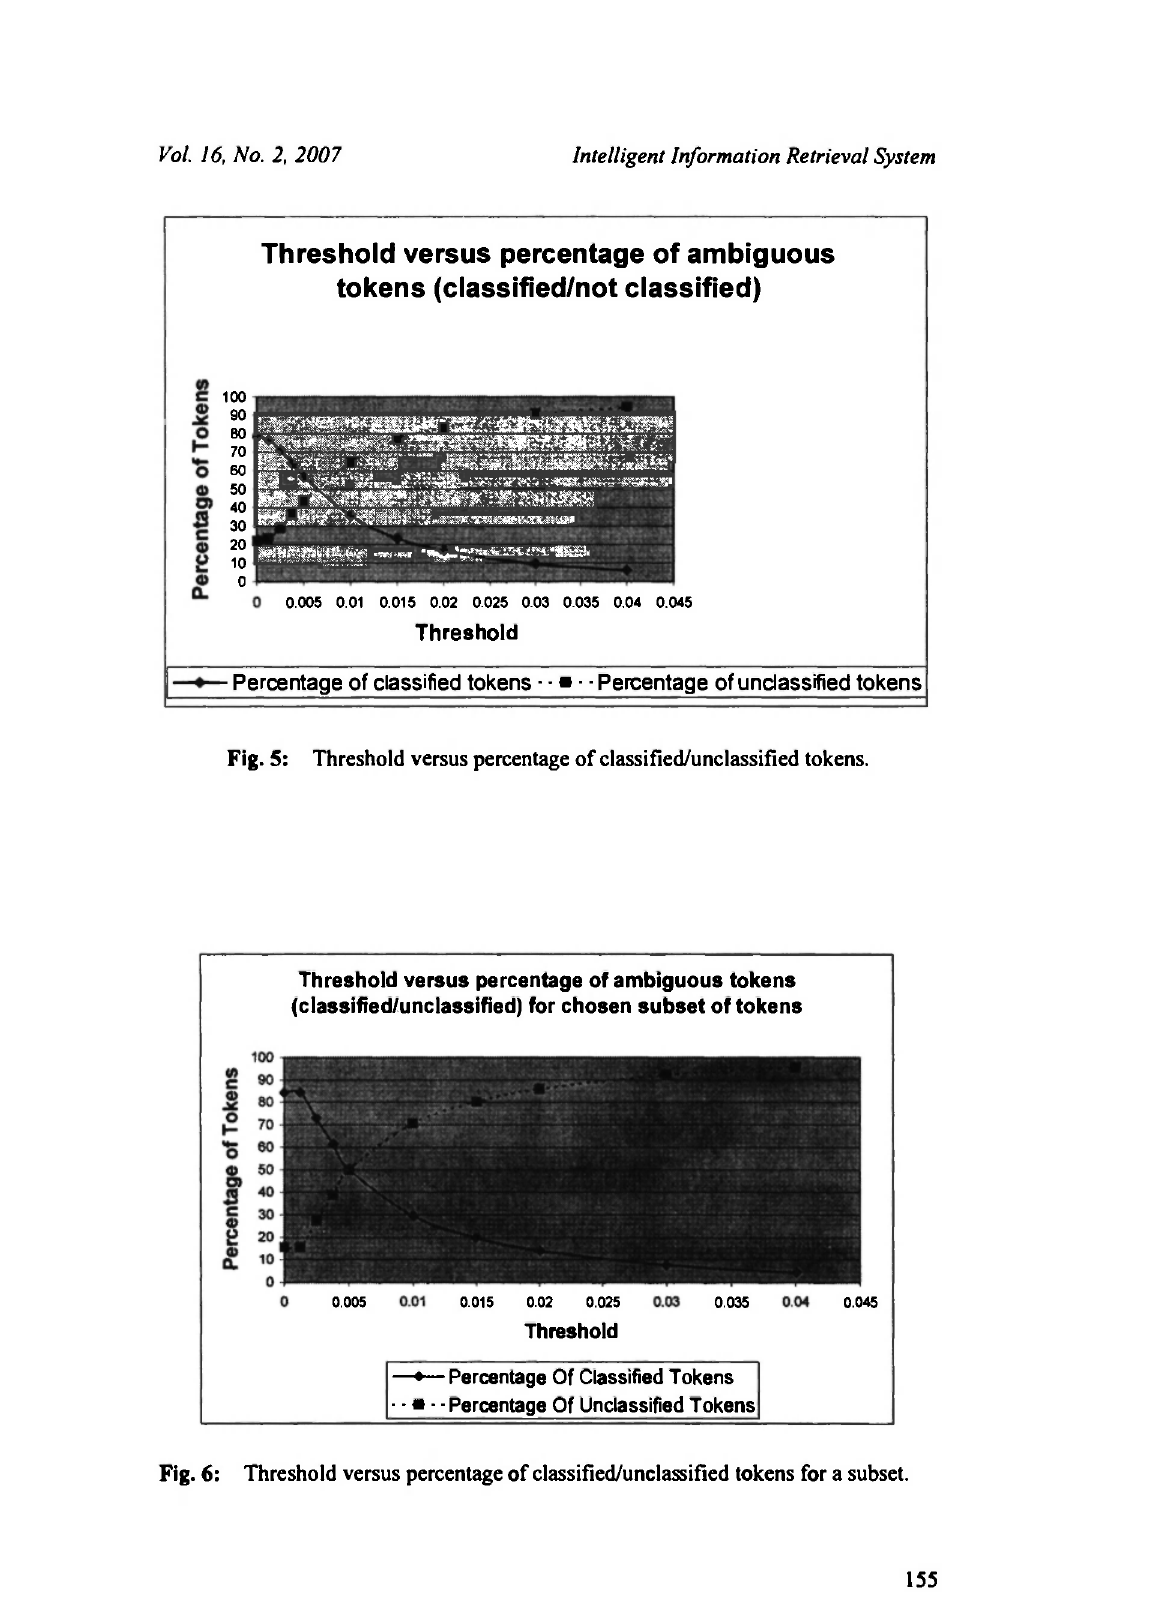
Fig. 6: Threshold versus percentage of classified/unclassified tokens for a